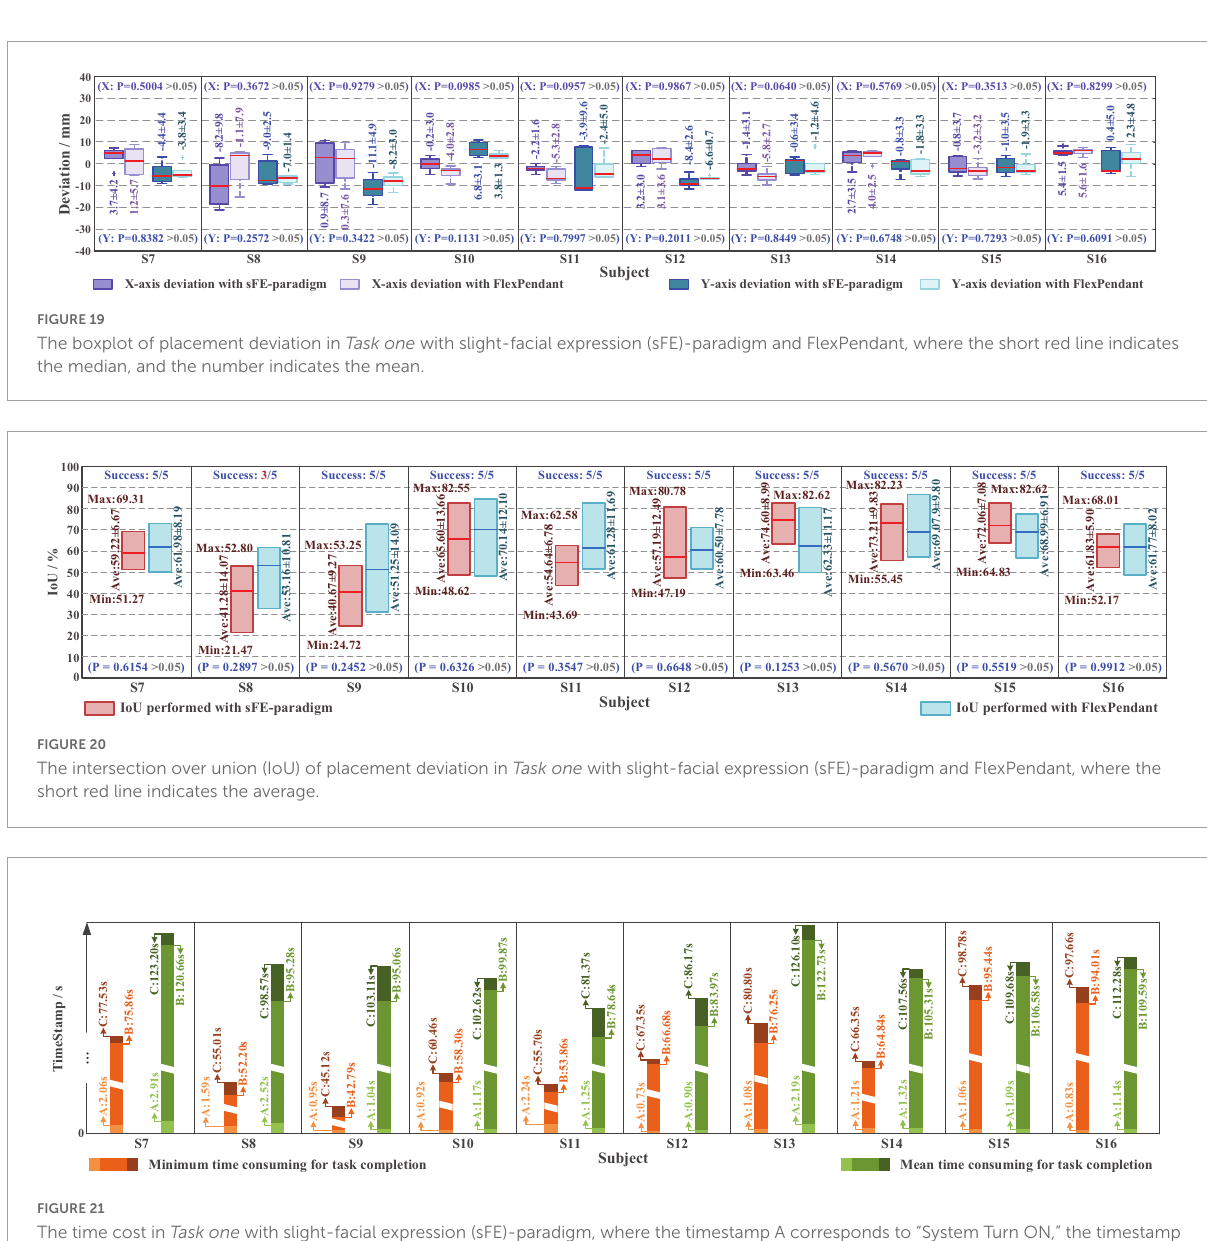
B and the block placement in Task one is demonstrated in Figure 20